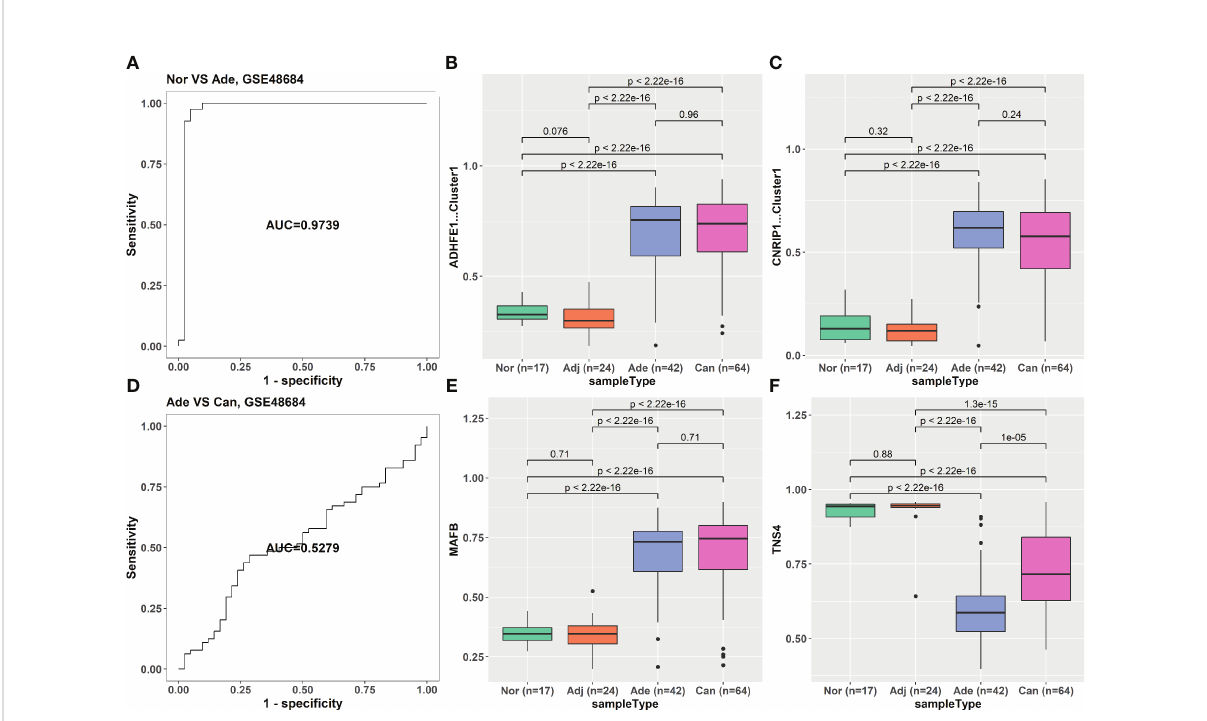
FIGURE 4 The classi fi cation ability and methylation levels of the four iRFE MDGs in GSE48684. (A) The classi fi cation performance of the LDA model for normal and adenoma samples. (D) The classi fi cation performance of the LDA model for adenoma and cancer tissues. (B, C, E, F) The methylation levels of the four iRFE MDGs in different tissues. (B) ADHFE1-Cluster1. (C) CNRIP1-Cluster1. (E) MAFB. (F) TNS4. Nor, healthy normal tissues; Adj, cancer-adjacent tissues; Ade, adenoma tissues; Can, cancer tissues; iRFE, iterative recursive feature elimination; MDGs, methylation-driven genes; LDA, linear discriminant